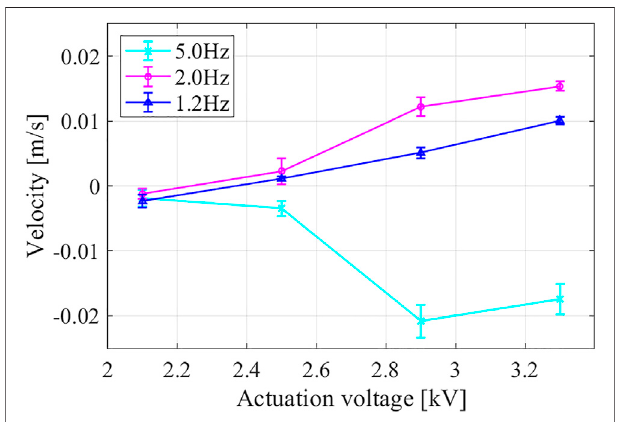
FIGURE11| Snapshotimages from thevoltage-basedlocomotion controldemo: theactuation frequency was2 Hz; theactuation voltage in(i), (ii),and (iii)was2.1 kV, and in (iv), (v), and (vi) was 3.3 kV.